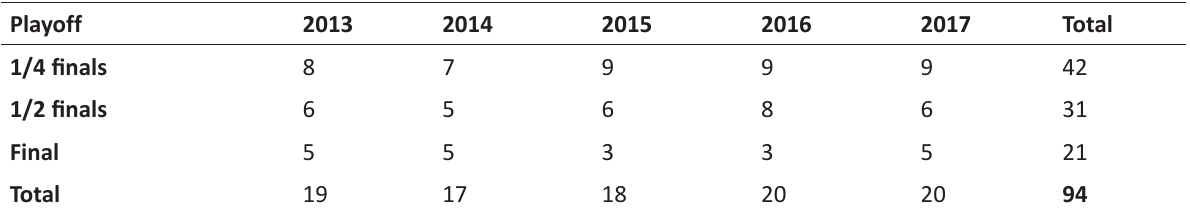
Table 2. The mean and difference values of the independent variables according to winner and loser teams. 2 Point